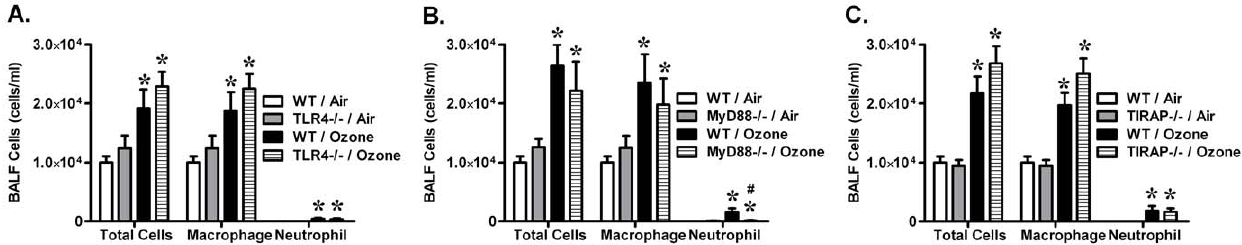
Figure 2. Ozone exposure increased neutrophilic lung inflammation in a manner partially dependent on MyD88, but not TLR4 and TIRAP. Ozone-exposed mice demonstrated increased neutrophil cell counts in BALF when compared to air-exposed animals. Neutrophil recruitment to the airspace was independent of TLR4 ( A ) and TIRAP ( C ), but was partially dependent of MyD88 ( B ) (* p , 0.05, vs. FA exposed group; # p , 0.05 vs. O